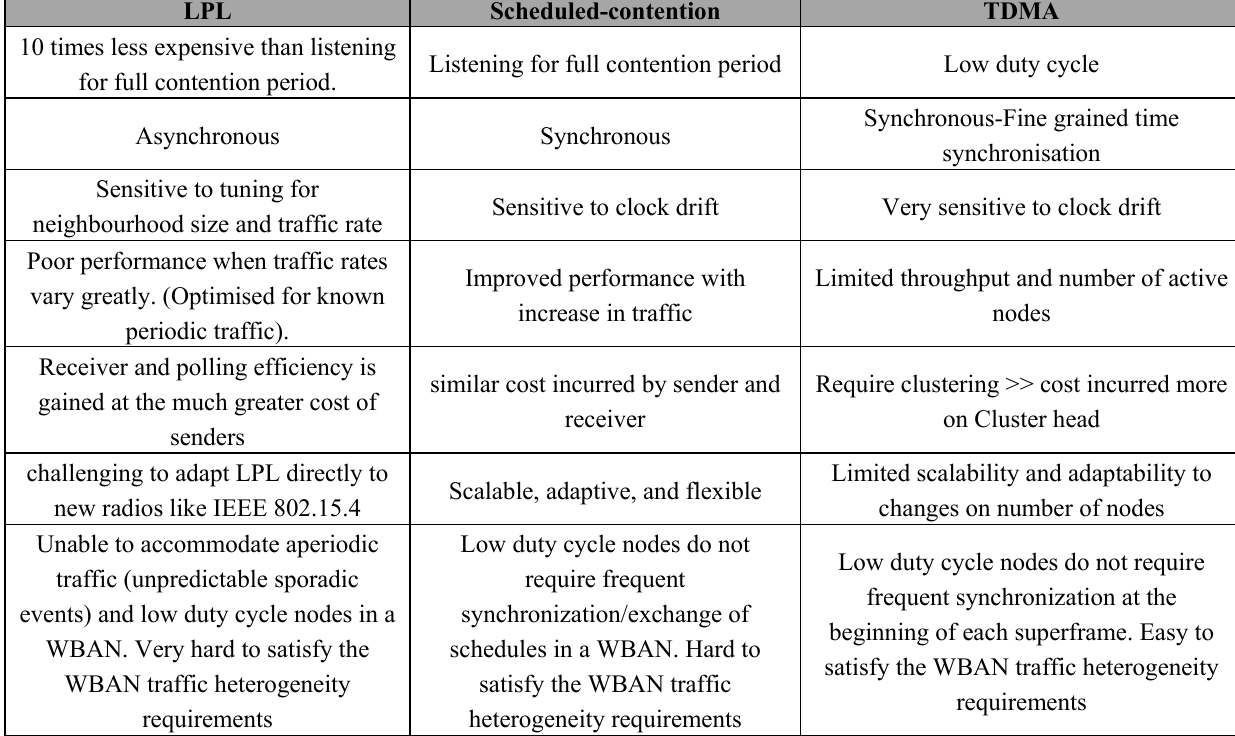
Table 6. Comparison of LPL, Scheduled-contention, and TDMA mechanisms for a WBAN. LPL Scheduled-contention TDMA 10 times less expensive than listening for full contention period.